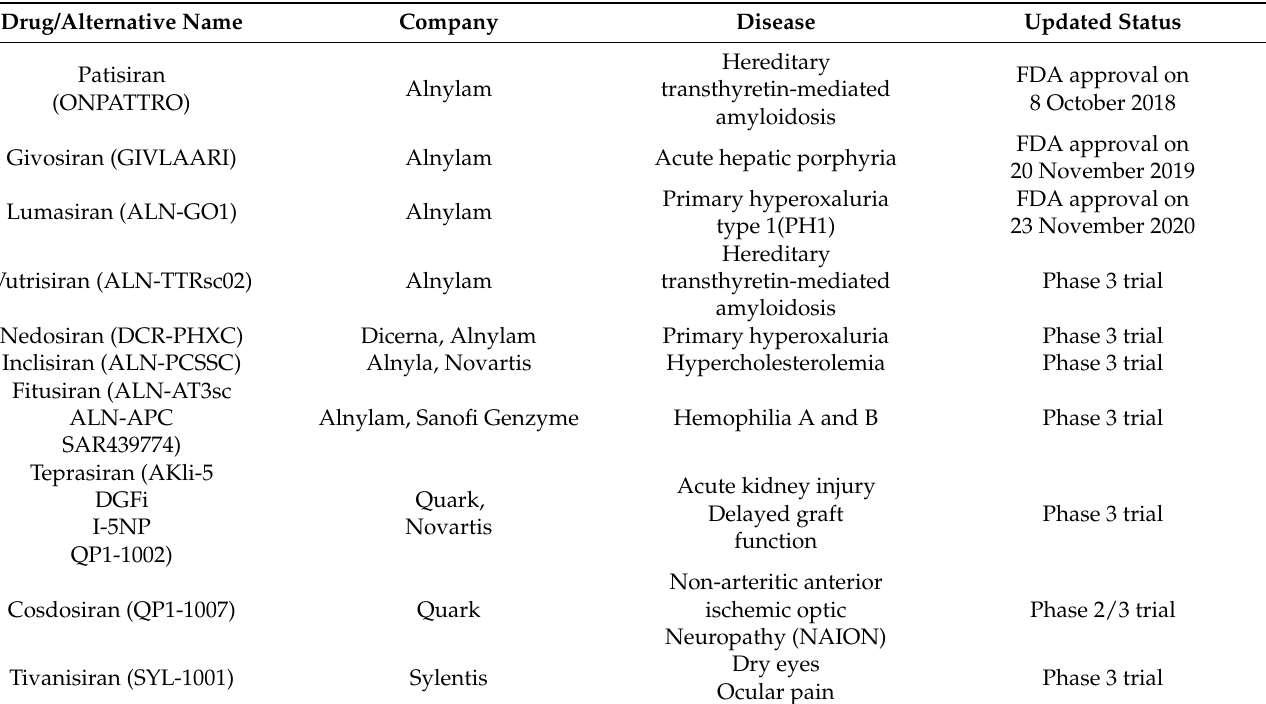
Table 1. A summary of the development of siRNA-based drugs with either FDA approval or in late phase 3 clinical trials. Reproduced with permission from